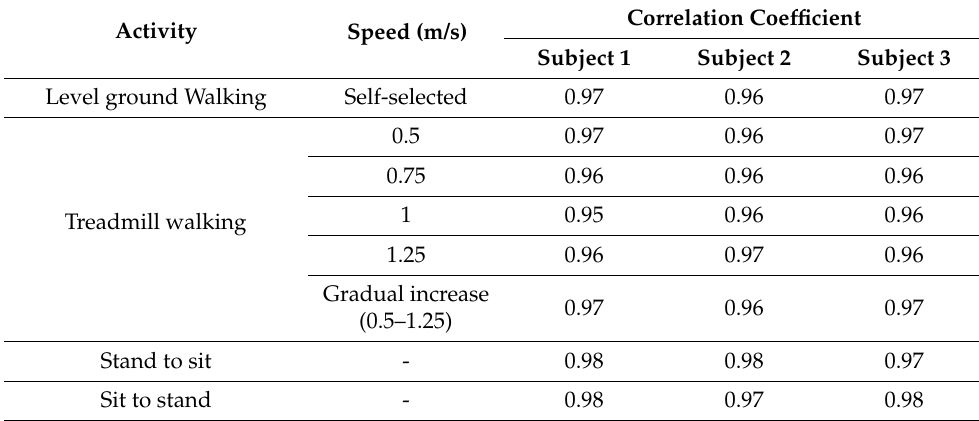
Figure 5. Comparison of Exo-skeleton’s ankle angle measurement with reference motion capture during walking. In this data, the correlation coefficient was calculated at 0.96. Table 2. The summary of Ankle angle measurement comparison (exoskeleton vs.